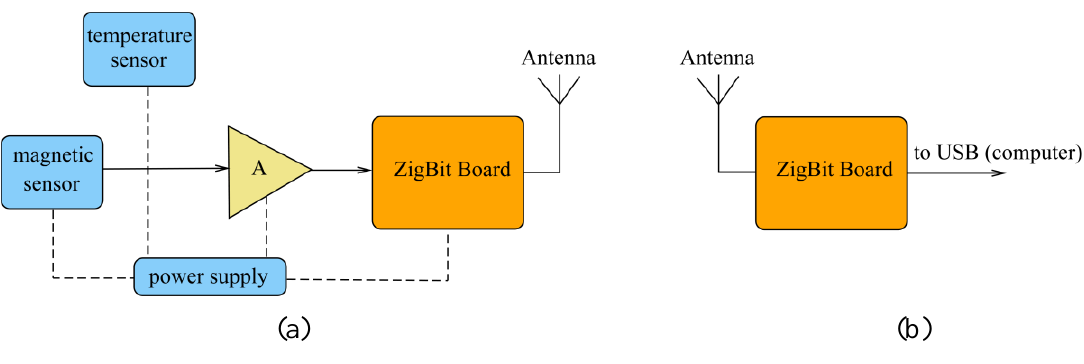
Figure 21. (a) End device. (b) Coordinator with